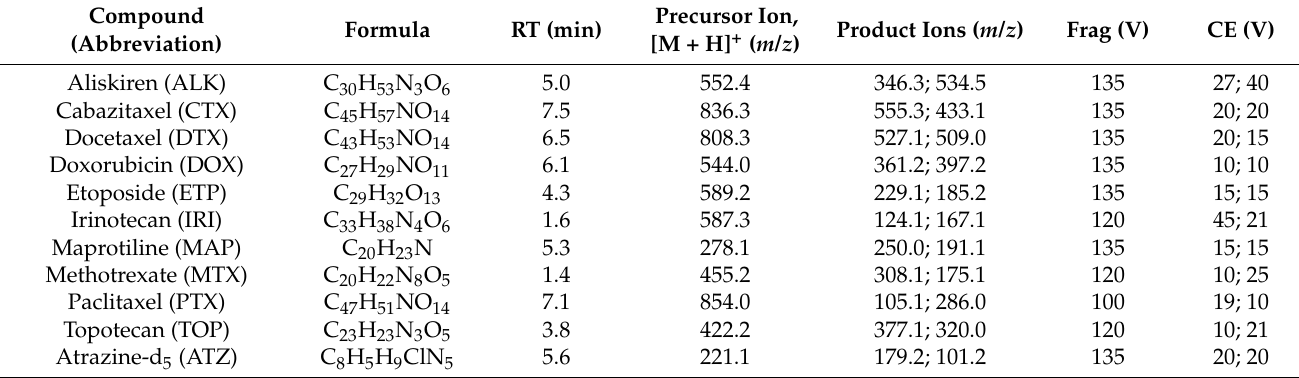
Table 2. Molecular formulas and the optimized LC-MS/MS parameters for analyzing the target pharmaceutical compounds. ATZ was used as the internal